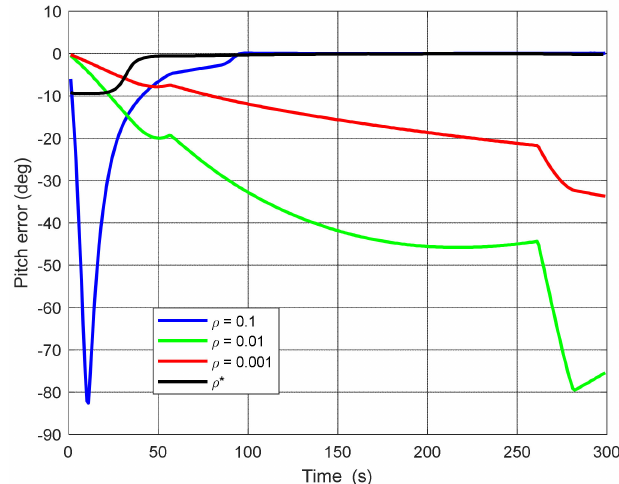
Figure 4. Pitch comparisons of different ρ .